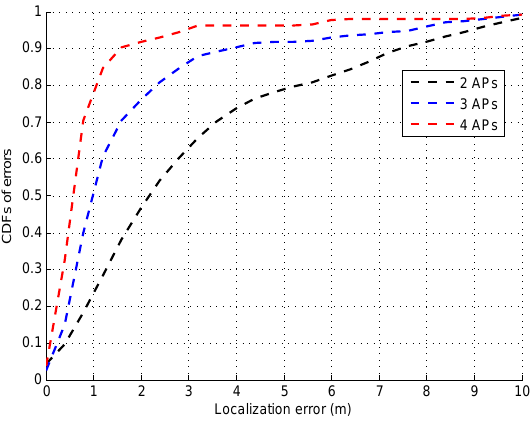
Figure 22. CDFs of errors under different AP number.